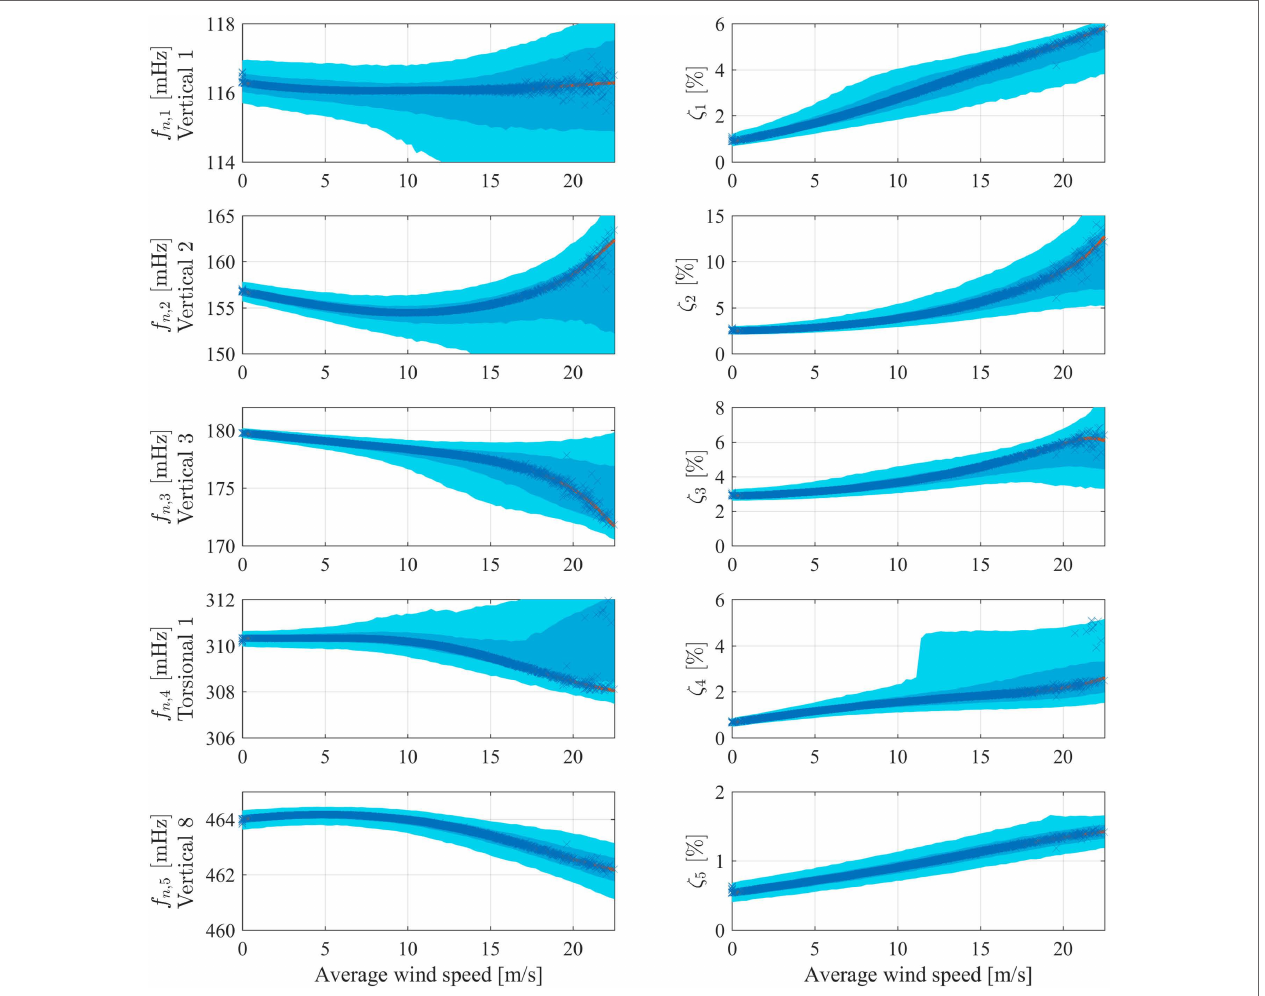
FIGURE 7 | Distribution of selected natural frequencies and damping ratios obtained from the GP-AR(72) p =4 model. Solid line, modal quantities from prior parameter estimates; dots, modal quantities from posterior parameter estimates; shaded areas, 50 and 90% confidence intervals derived from the parameter mean and covariance matrix. Left column: natural frequencies in mHz; right column: damping